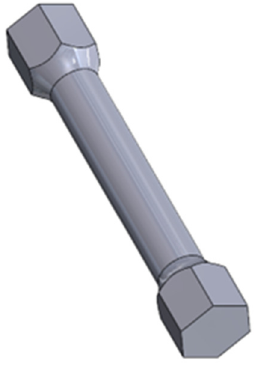
Figure 1. Monolithic specimen (PM_Samples).